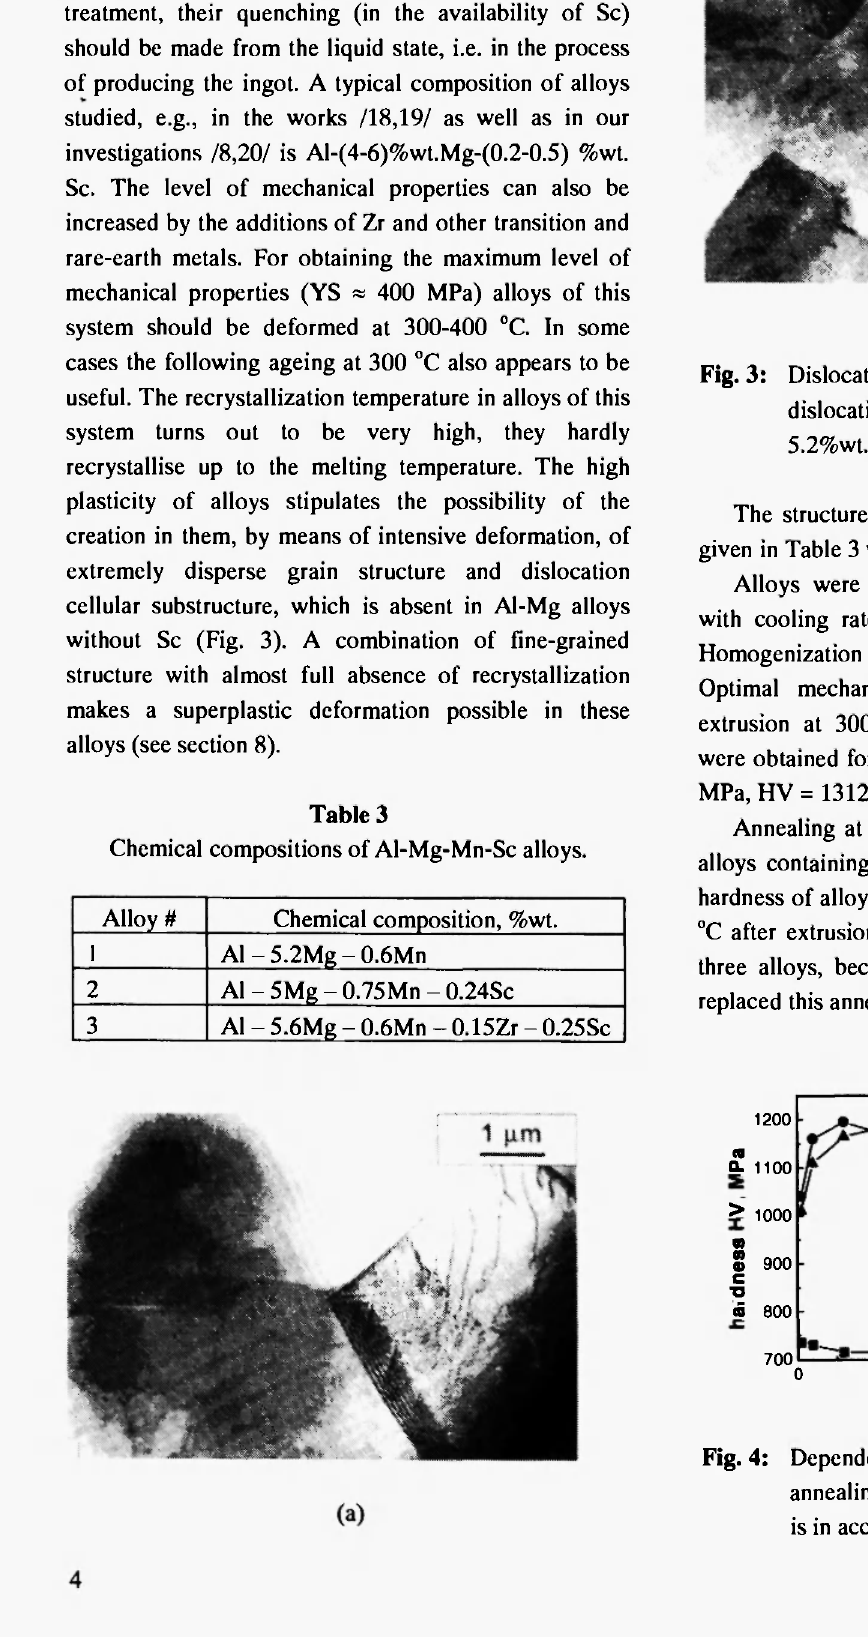
Fig. 4: Dependence of hardness cast alloys on annealing time at 300 °C. Numeration of alloys is in accordance with Table